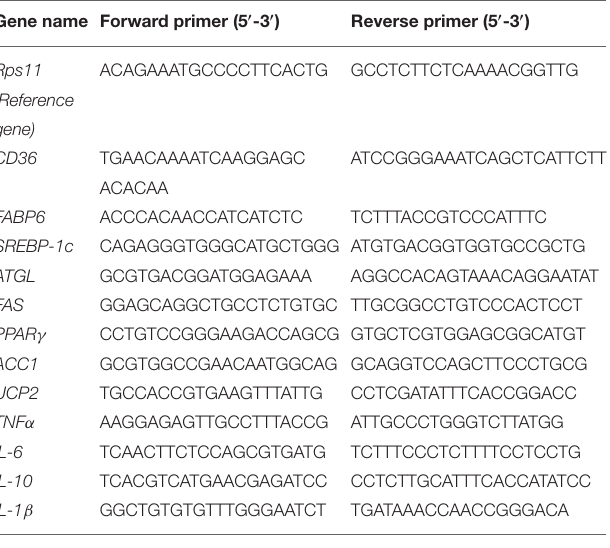
TABLE 1 | Ingredient and nutrient composition of the basal diet and high-fat diet. Ingredients (g/kg diet)